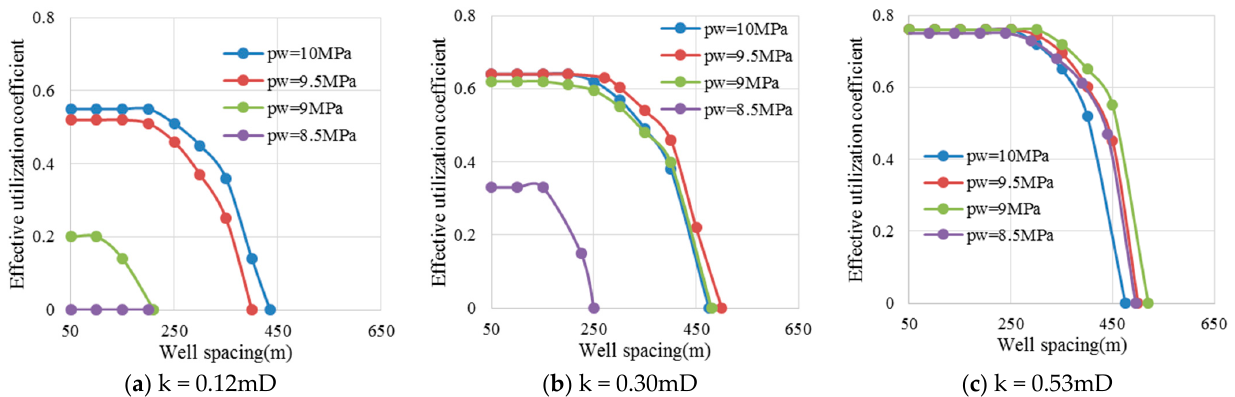
Figure 21. The relationship between the effective utilization coefficient and the well spacing after fracturing.